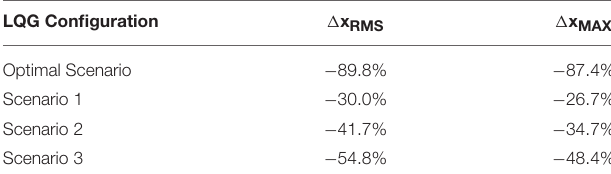
TABLE 1 | Summary of mean improvements to structural performance during LQG controller parametric investigation.